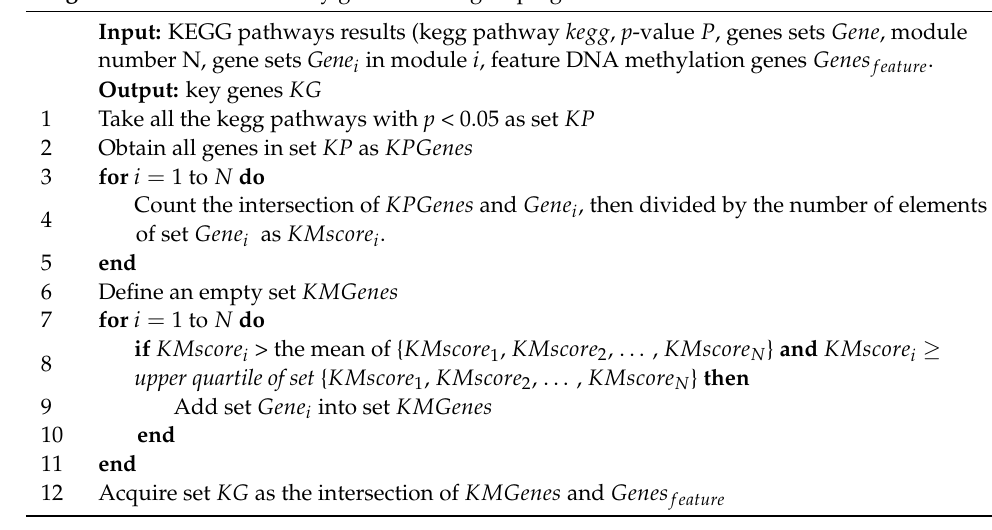
Algorithm 1 : Selection of key genes for subgrouping.